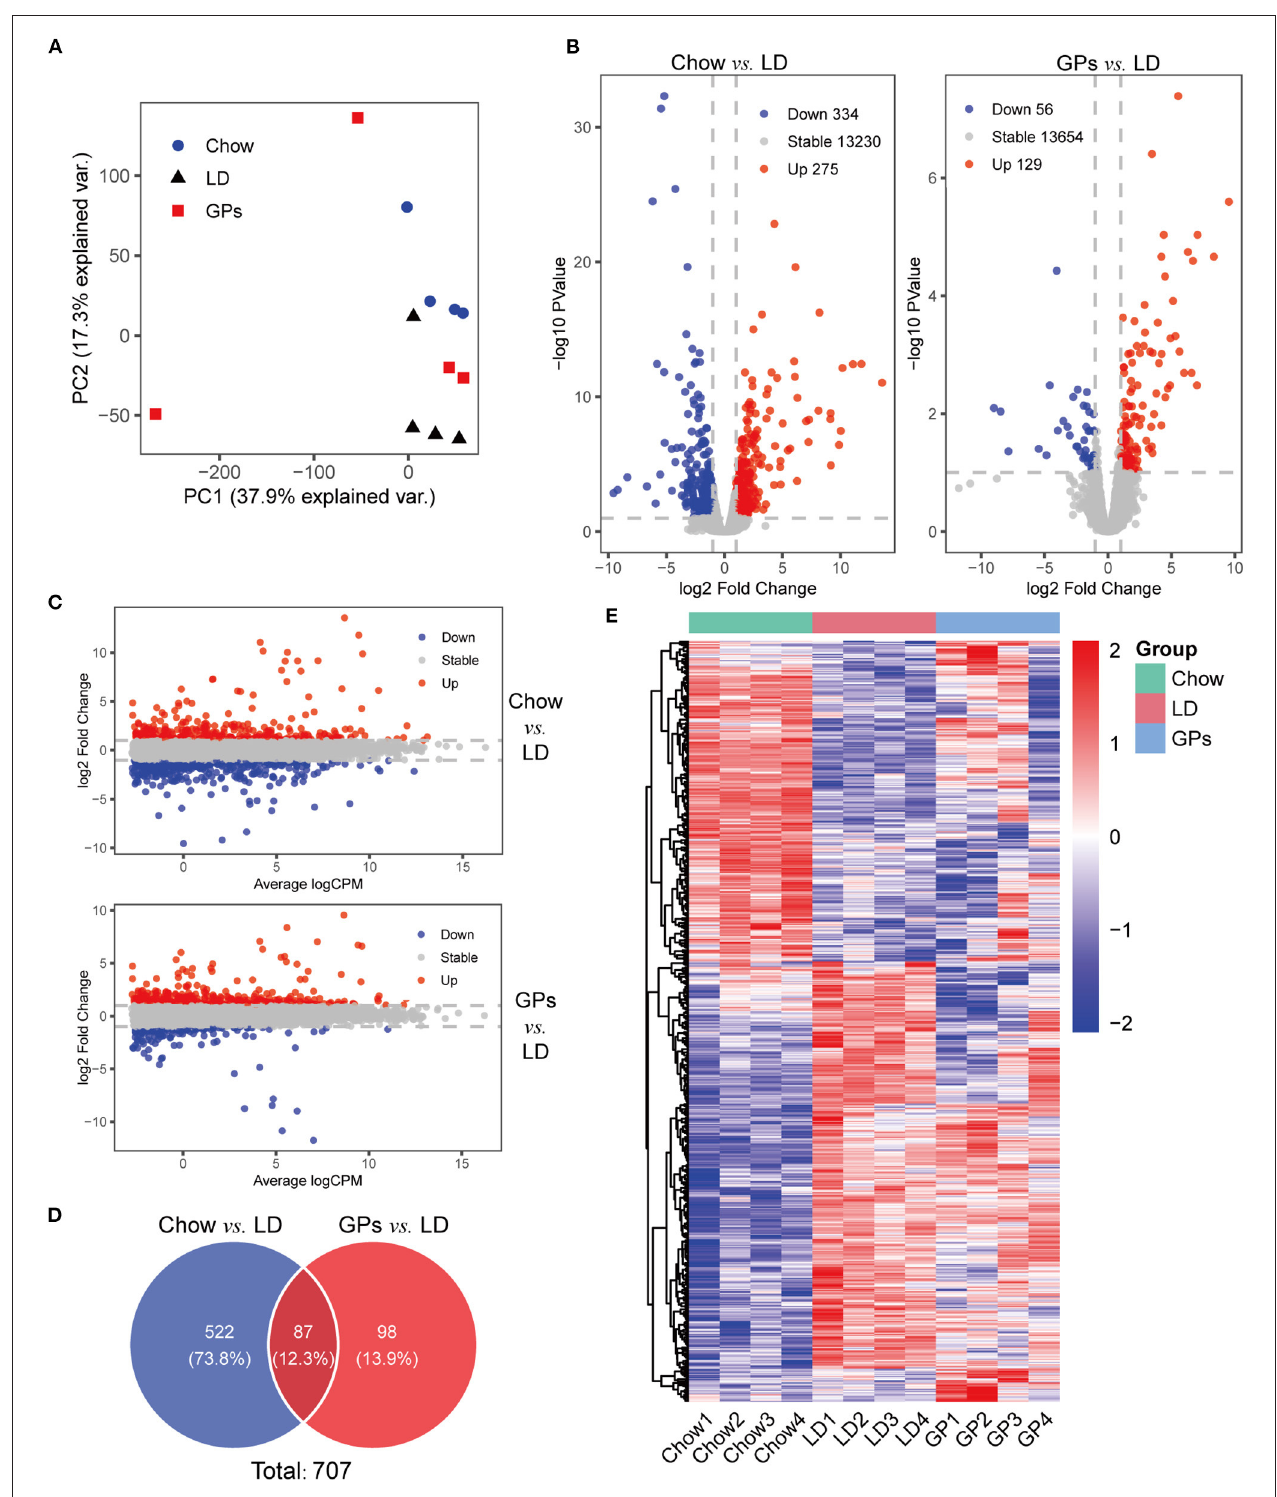
FIGURE 4 | RNA sequencing (RNA-seq) analyses of liver tissue. (A) Principal component analysis (PCA) of the RNA-seq results. (B) Volcano plots of differentially expressed genes in the Chow and LD groups and in the GPs and LD groups (FDR < 0.1, log2 Fold Change > 1). (C) M-v-.A plots. (D) Venn diagrams. (E) Heatmap of the 707 differentially expressed genes from the two sets of comparisons. CPM, counts per